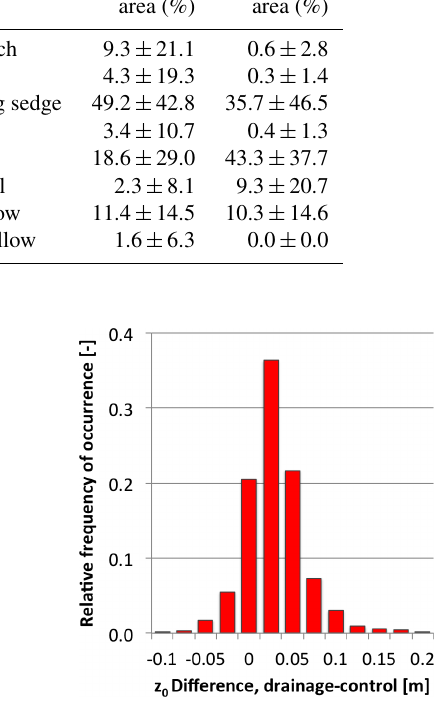
Figure 5. Frequency distribution of the shifts in aerodynamic roughness length z 0 (drained–control) in the drained area, compared to the control area. Data covers the months June through September in